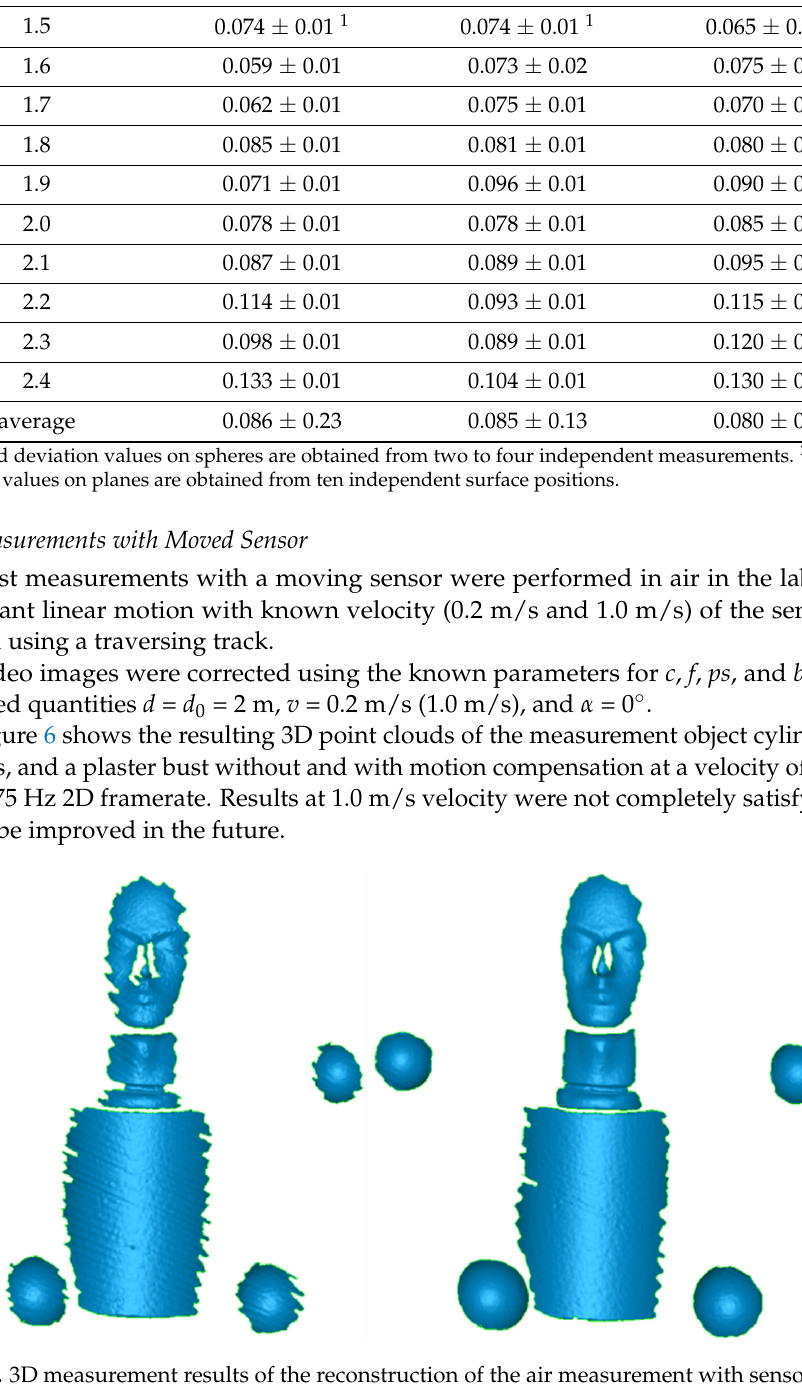
Figure 6. 3D measurement results of the reconstruction of the air measurement with sensor velocity of 0.2 m/s without motion compensation ( left ) and with motion compensation ( right ). Note the higher completeness at the margins of the objects with motion compensation.